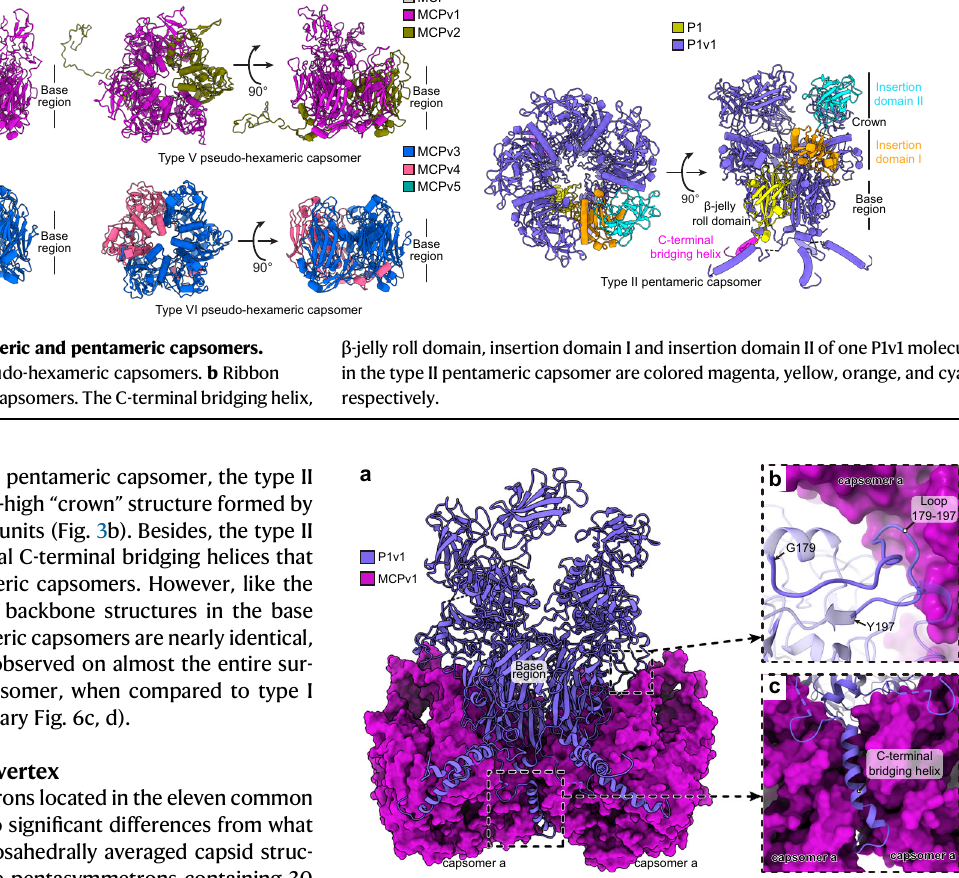
Fig.4|AssociationsbetweenthetypeIIpentamericcapsomerandneighboring pseudo-hexameric capsomer a in the unique vertex. a Structures of the type II pentameric capsomer (corn fl ower blue) and its two adjacent pseudo-hexameric capsomers(magenta). b , c Zoomed-inviewsoftheboxedregionsin a ,showingthe contacts between the loop 179 – 197 ( b ), C-terminal bridging helix ( c ) of P1v1, and capsomer